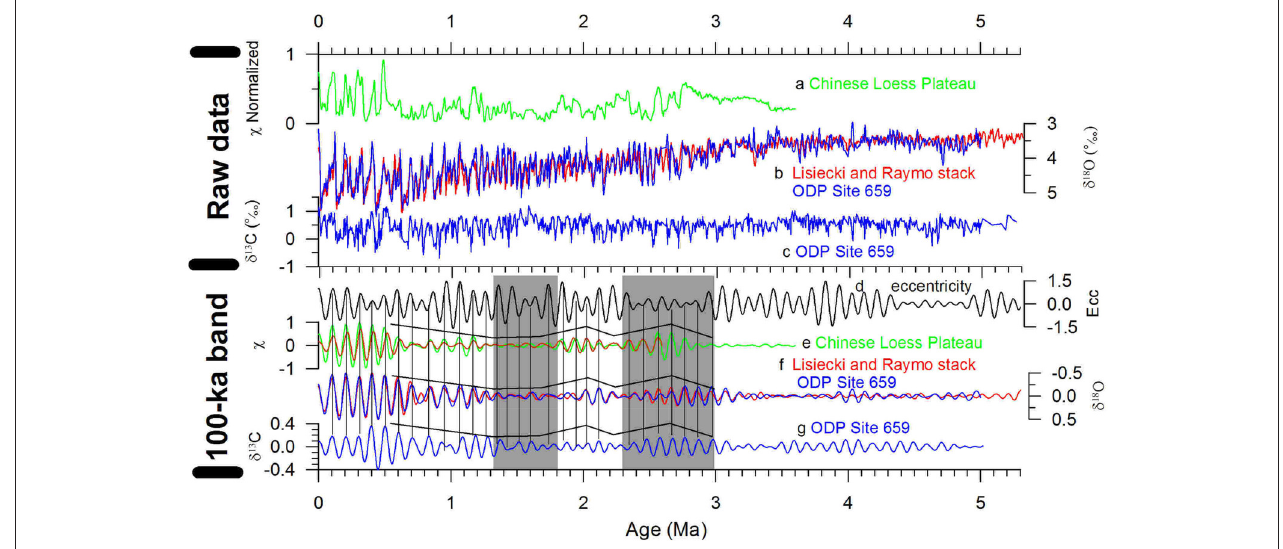
FIGURE 7 | Paleoclimate time series and the 100-kyr band variability associated with each record (Nie, 2011). (A) The χ stack record of Sun et al. (2006) from the CLP. (B) Benthic δ 18 O record from ODP Site 659 (blue) and benthic δ 18 O stack record synthesized by Lisiecki and Raymo (2005) (red). (C) Benthic δ 13 C time series from ODP Site 659. Benthic δ 13 C is generally used as a proxy for paleo-ocean circulation change/global carbon mass balance ( Tiedemann et al., 1994; Piotrowski et al., 2005 ). (D) The filtered 100-kyr band variability of Earth’s orbital eccentricity (Laskar, 1990). (E–G) The filtered 100-kyr band of variability of (A–C) , respectively. In (E) the filtered 100-kyr band of variability of the Chaona χ record is also shown for comparison (brown). Note that there is weak forcing but strong response from 3 to 2.3 Ma (the shaded bar), and strong forcing but weak response from 1.8 to 1.3 Ma (the shaded bar). The trend lines in (E–G) indicate coupled amplitude variation in these three data